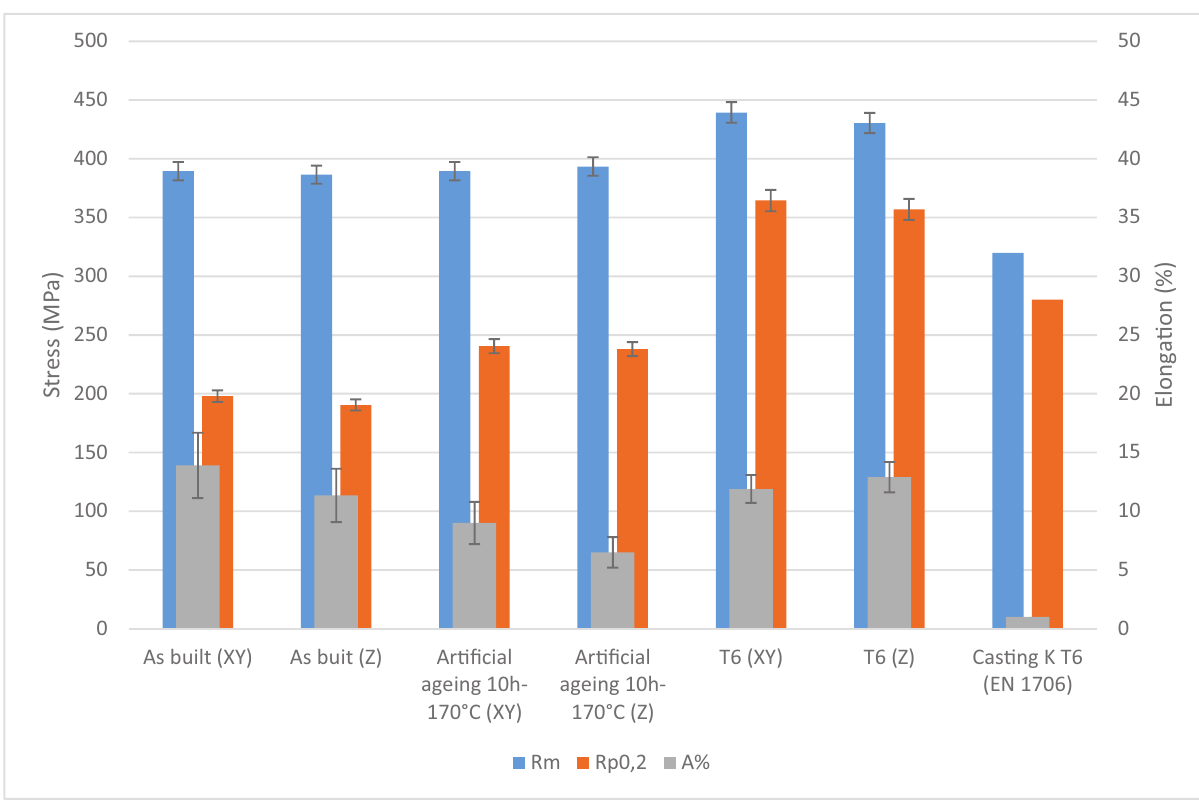
Fig. 7. Static mechanical properties of the AlSi5Cu3Mg alloy for different